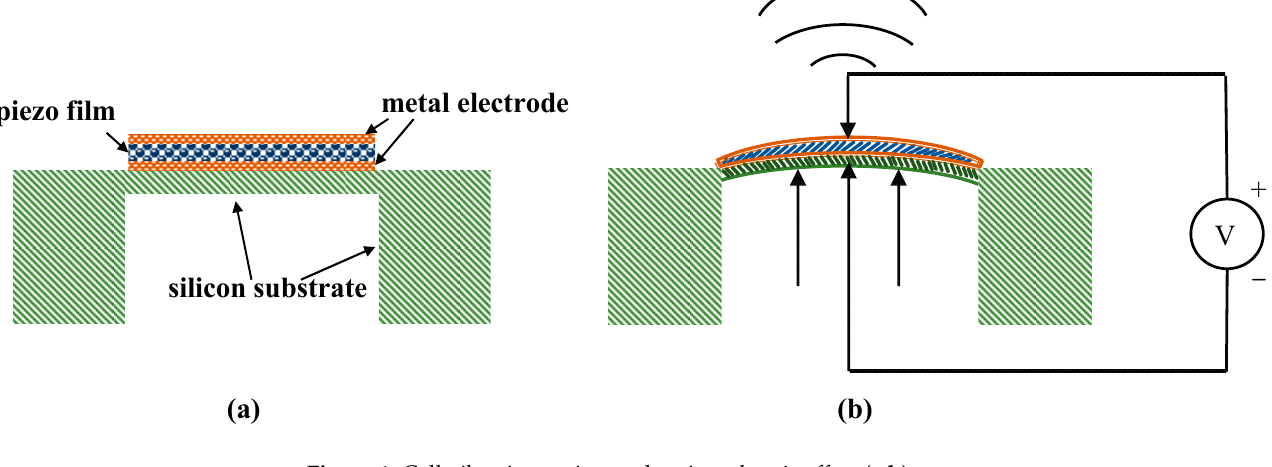
Figure 1. Cell vibration owing to the piezoelectric effect ( a , b ).